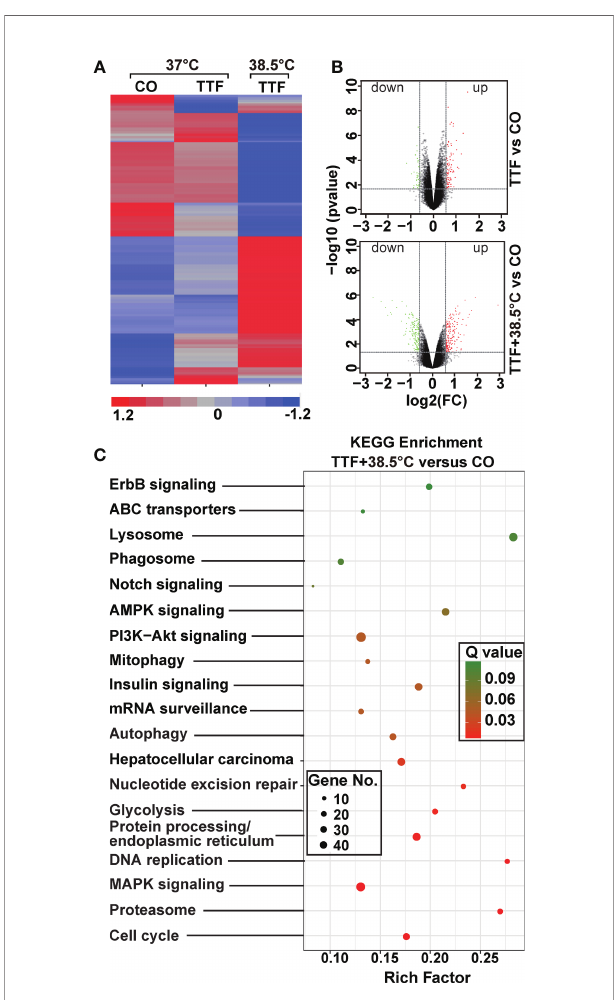
FIGURE 4 | Gene array analysis demonstrates that hyperthemia enhances TTField-induced differential gene expression. (A) BxGEM cells were cultivated at 37°C in the absence (CO) or presence of TTFields (TTF) or were cultured at 38.5°C in the presence of TTFields (TTF+38.5°C) for 72 hours. Then, the mRNA was isolated, and gene array analysis was performed, followed by analysis of differentially regulated genes with a fold change of at least 1.5 and a signi fi cance of P < 0.05. Hierarchical cluster analysis was performed to organize the genes into clusters based on their expression similarities. Red: gene upregulation; Lilac: gene downregulation within a scale of 1.2 to -1.2. (B) Volcano plots were created and show the distribution of differentially expressed mRNAs in BxPc-3 cells cultured at 37°C in the absence (CO) or presence of TTFields (TTF vs CO) or at 38.5°C in the presence of TTFields (TTF +38.5°C vs CO). Red: (upregulated genes); Green (downregulated genes). The X-axis represents the expression pro fi les of multiple genes. The Y-axis represents the magnitude of gene expression changes. FC = 1.5, P < 0.05. (C) A KEGG enrichment analysis was performed to compare differentially regulated pathways between cells treated with TTFields + 38.5°C and control cells, which were cultivated at 37°C. The X-axis represents the rich factor, and the Y ‐ axis represents the KEGG terms. Rich factor: ratio of differentially expressed gene numbers annotated in this pathway term to all gene numbers annotated in this pathway term. The greater the Rich factor, the greater the degree of pathway enrichment. The size of the circles increases with the gene count. Different circle colors represent distinct Q values as